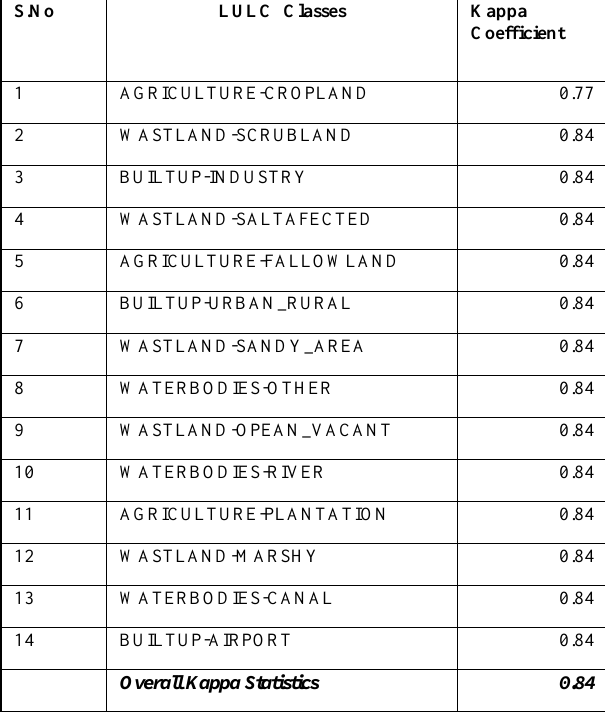
Table 2. Kappa Statistics of Landuse Landcover